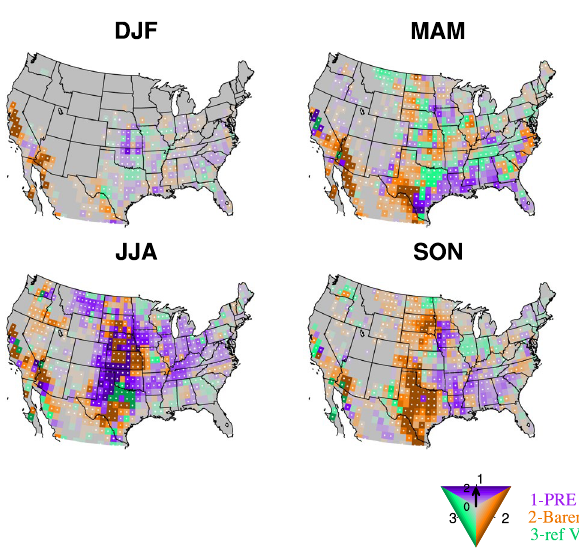
Figure 3. Dominant contributors to the variations of dust event frequency. Regression coefficients are obtained by regressing the dust event frequency in each season onto the standardized precipitation (purple), bareness (orange), and surface wind speed (green) from 2004 to 2015. The color of the shading denotes the largest coefficient in absolute value among the three while the saturation of the color shows the magnitude of the coefficient (from 0 to 2). Regression coefficients significant at the 90% confidence level (Bootstrap test) are dotted. Missing values are shaded in grey. Maps were generated using the NCAR Command Language (NCL; https://www.ncl.ucar.edu/), version